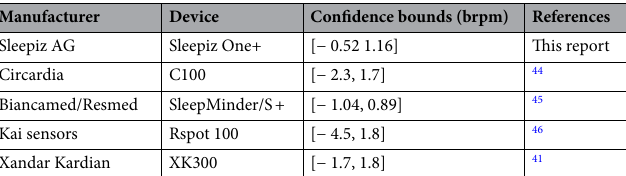
Table 5. Performance comparison of instantaneous respiratory rate estimation among radar-based medical